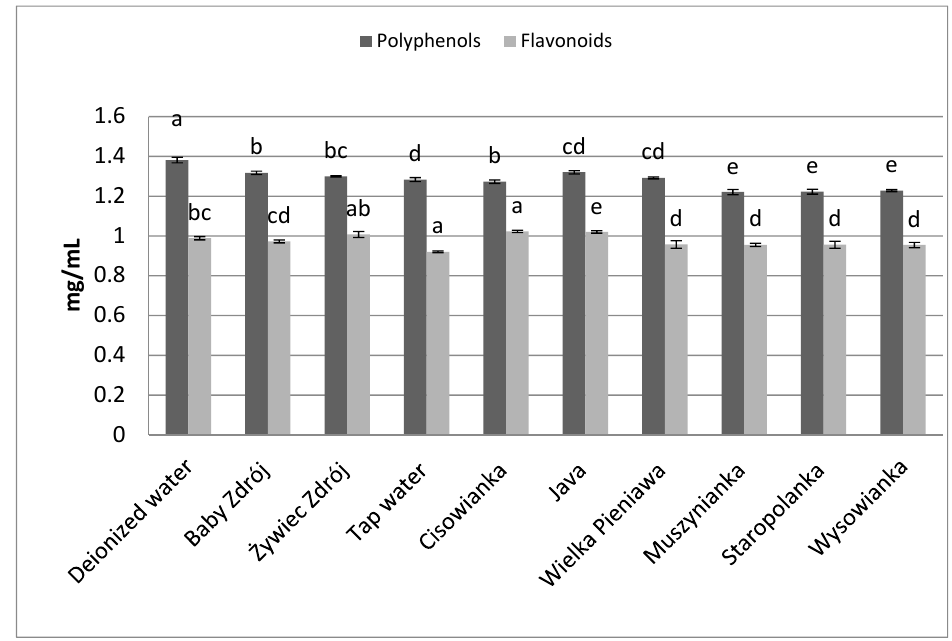
Figure 8. The effect of water mineralization on the extraction of active substances from leaves of sage. Data are shown as mean ± SD. Different letters (a, b, c, etc.) show a significant difference with p < 0.05. The differences relate to each group of compounds separately.